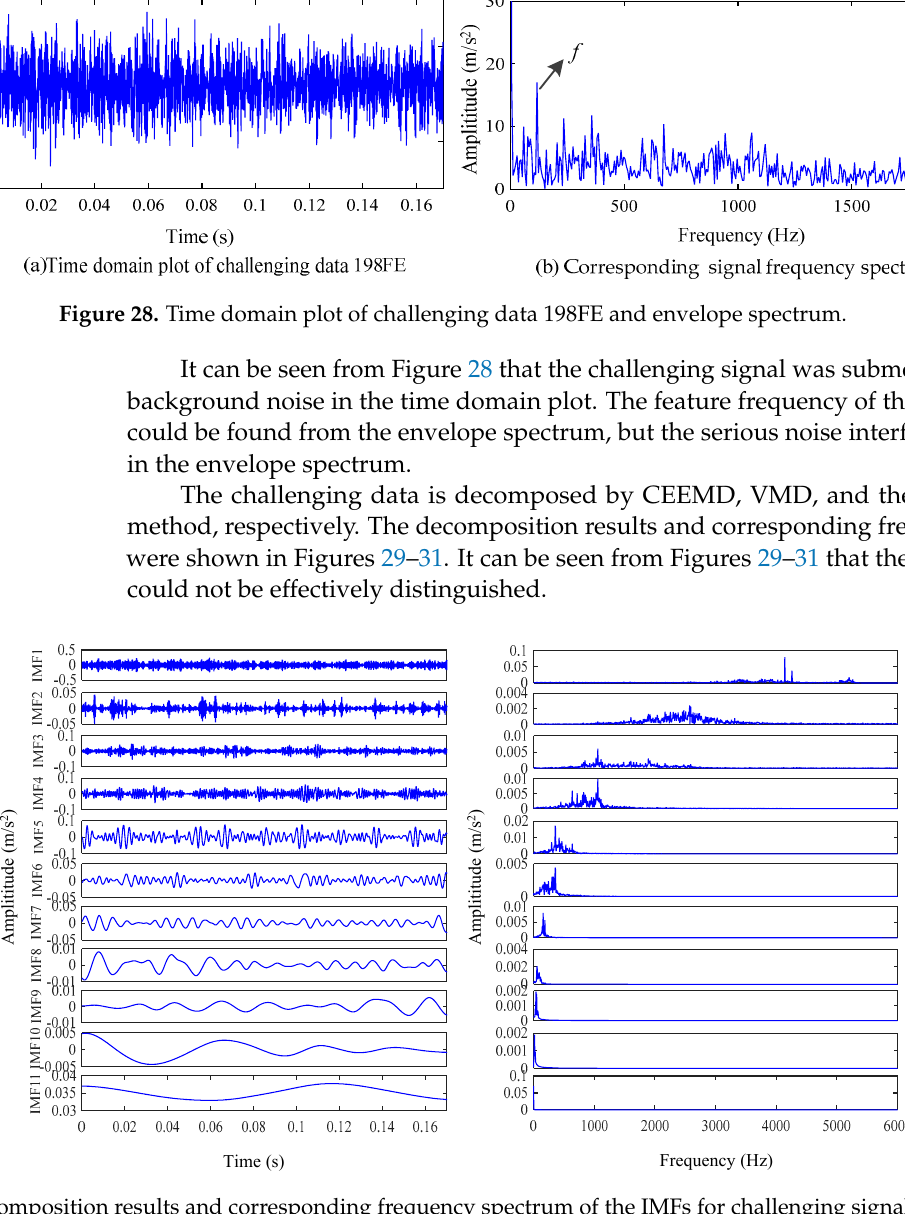
Figure 29. Decomposition results and corresponding frequency spectrum of the IMFs for challenging signal with CEEMD.